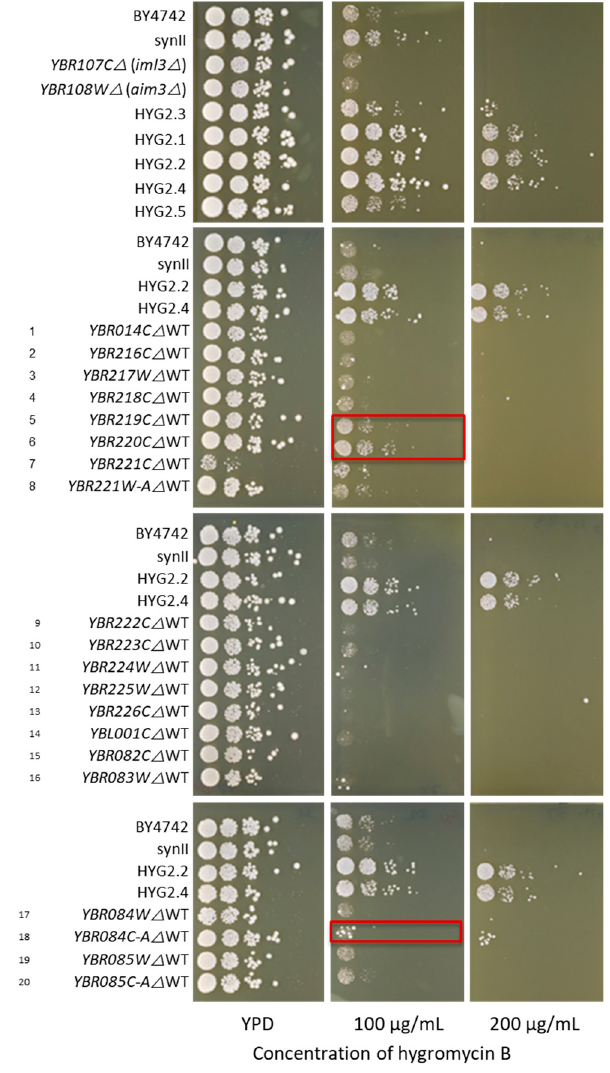
Figure 4. Phenotypic analysis showed that YBR219C ∆ WT , YBR220C ∆ WT and YBR084C-A ∆ WT contributed to hygromycin B resistance. Single knockout strains, BY4742, synII, SCRaMbLEd strains were spotted on YPD plates containing different concentrations of hygromycin B. Plates were incubated at 30 ℃ and the photos were taken on day 3. The increased of hygromycin B resistance is slightly increased when YBR219C ∆ WT, YBR220C ∆ WT and YBR084C-A ∆ WT were deleted in- dividually from the WT strain. The hygromycin B resistance is significantly higher in the SCRaMbLEd strains HYG2.2 and HYG2.4 compared to single deletion strains.